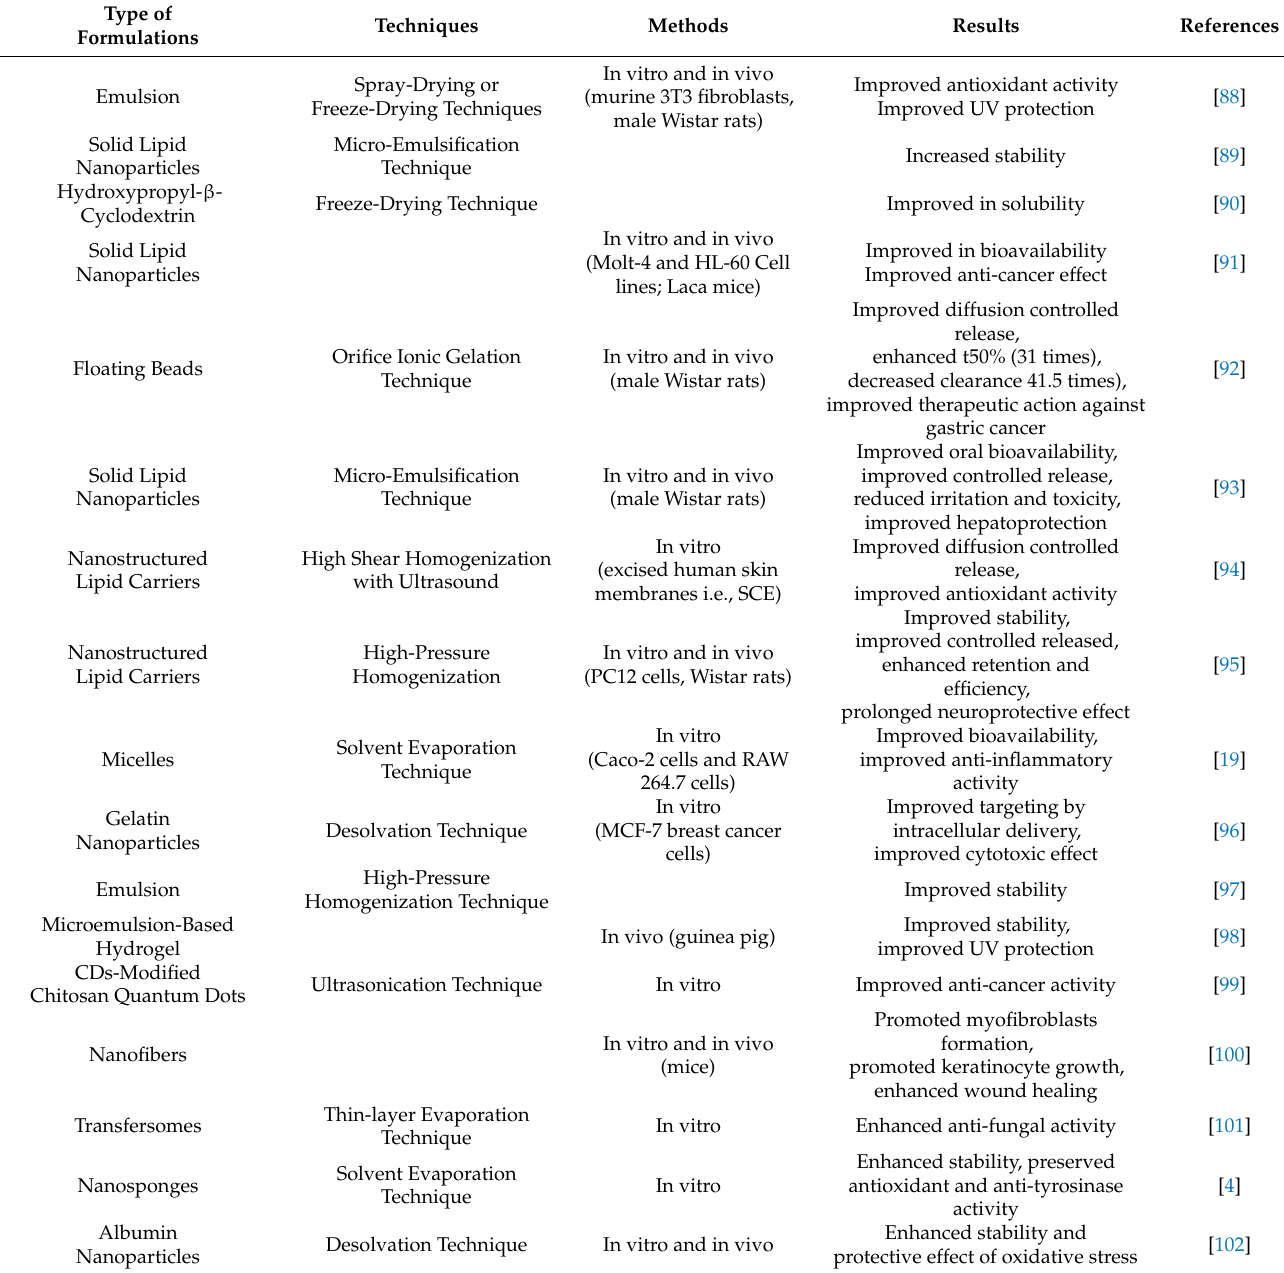
Table 1. Novel Formulations of